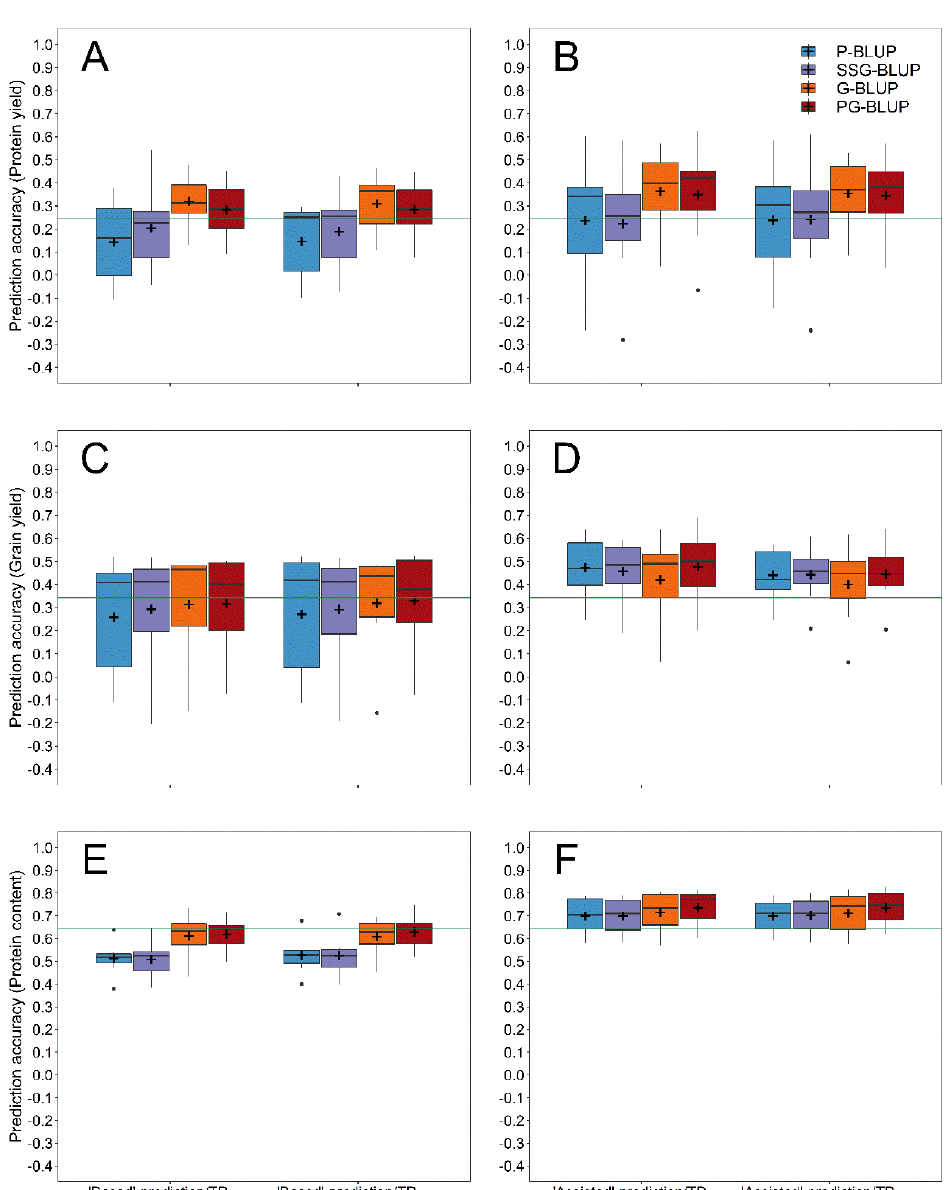
Figure 5. Prediction accuracy for protein yield ( A , B ), grain yield ( C , D ) and protein content ( E , F ) using pedigree (P-BLUP), single-step (SSG-BLUP), genomic (G-BLUP) and pedigree-genomic (PG-BLUP) forward predictions with an accumulating training population of lines coming from all years preceding the validation years 2013–2019 in comparison with the predictive performance of phenotypic selection based on preliminary yield trials (green horizontal line). The employed training populations included all available lines tested in multi-environment trials preceding a specific validation year, whereas both scenarios without (TP small ) or with augmenting the training population with lines tested in all preliminary yield trials preceding a validation year (TP large ) were considered. All prediction models were fitted either without including preexisting information of a specific validation population from the preliminary yield trial preceding the validation year (“Based”-predictions) or with including this source of phenotypic information into the training population